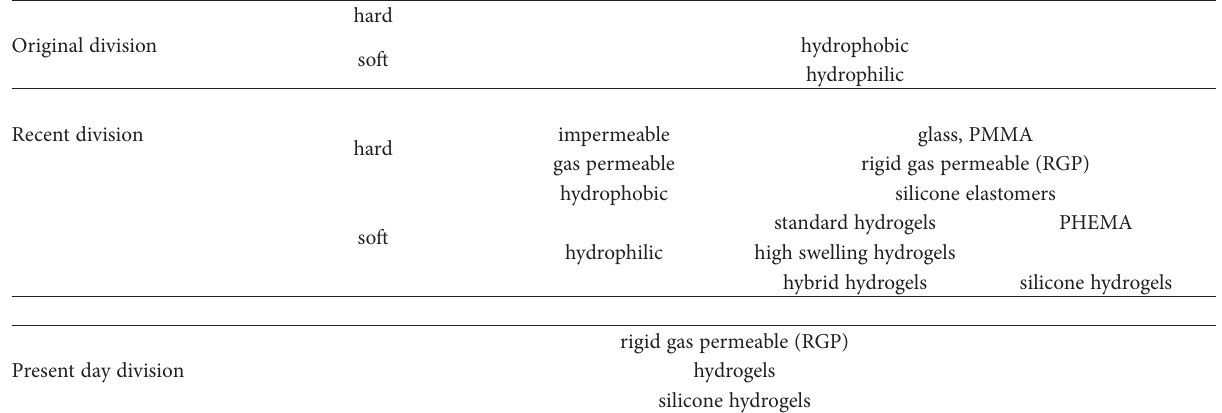
Table I. Categorization of contact lenses from the material point of view. How it changed in time